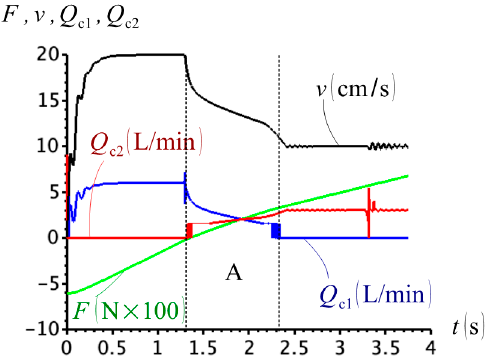
Figure 7. External force, F, cylinder velocity, v , and check valve flows, Q c1 and Q c2 , for m = 250 kg .